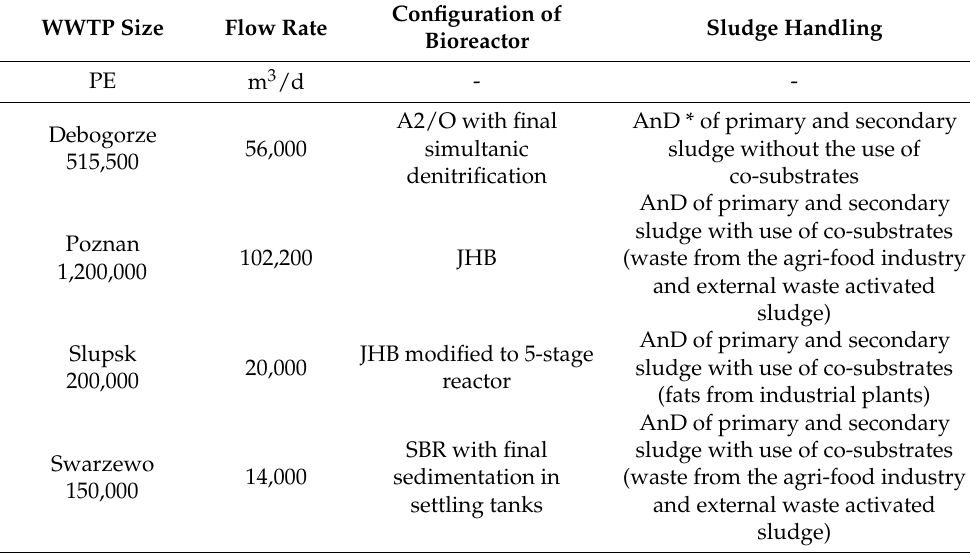
Table 1. Basic characteristics of the studied